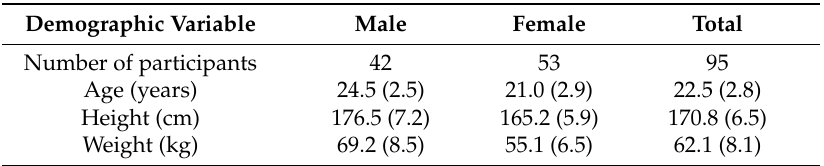
Table 1. Mean (SD) of participants’ demographic information, including the number of participants, age, height, and